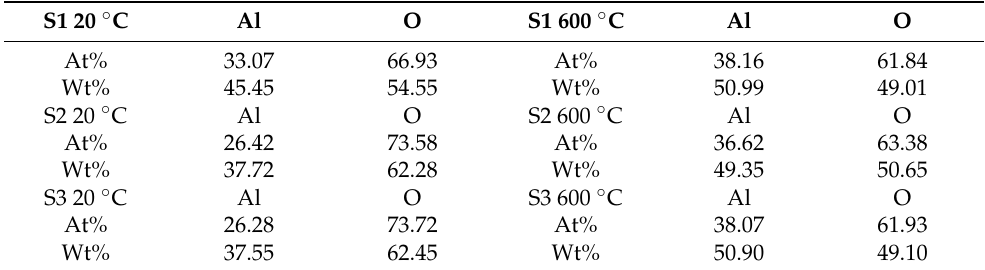
Table 1. Electron Dispersive Spectroscopy (EDS) microanalysis.